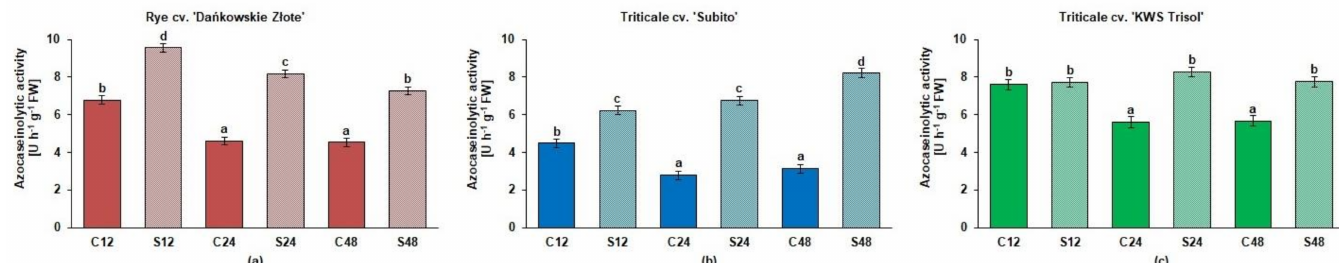
Figure 3. The azocaseinolytic activity at pH 5.2 [U h − 1 g − 1 fresh shoot weight FW] in root extracts of cereals at 12, 24 and 48 h after treatment with Al 3+ (0.59 mM) (S) and in untreated plants (C). Results are shown as means ± confidence intervals. Different letters indicate significant differences among values after one-way analysis of variance and Tukey’s honestly significant difference procedure at p < 0.05. ( a ) tolerant rye cv. “Da´nkowskie Złote”; ( b ) sensitive triticale cv. “Subito”; ( c ) tolerant triticale cv. “KWS